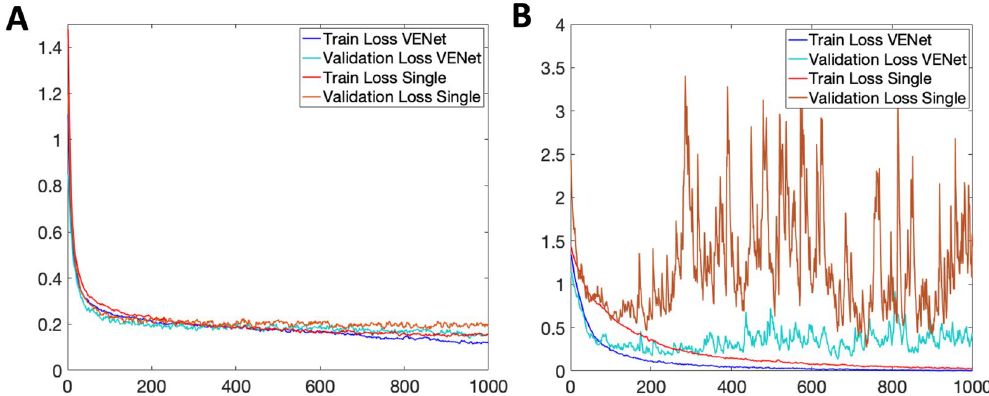
Figure 5. Comparison of loss curves of the training of single task DCNN (VENetS and VENetC for segmentation and classification, respectively) against the proposed multitask VENet. ( A ) Loss curves on the training/validation dataset for the segmentation task; ( B ) Loss curves on the training/validation dataset for the classification task. Note that, to ease interpretation, the segmentation loss curve was shifted up to have 0 as the minimum value.